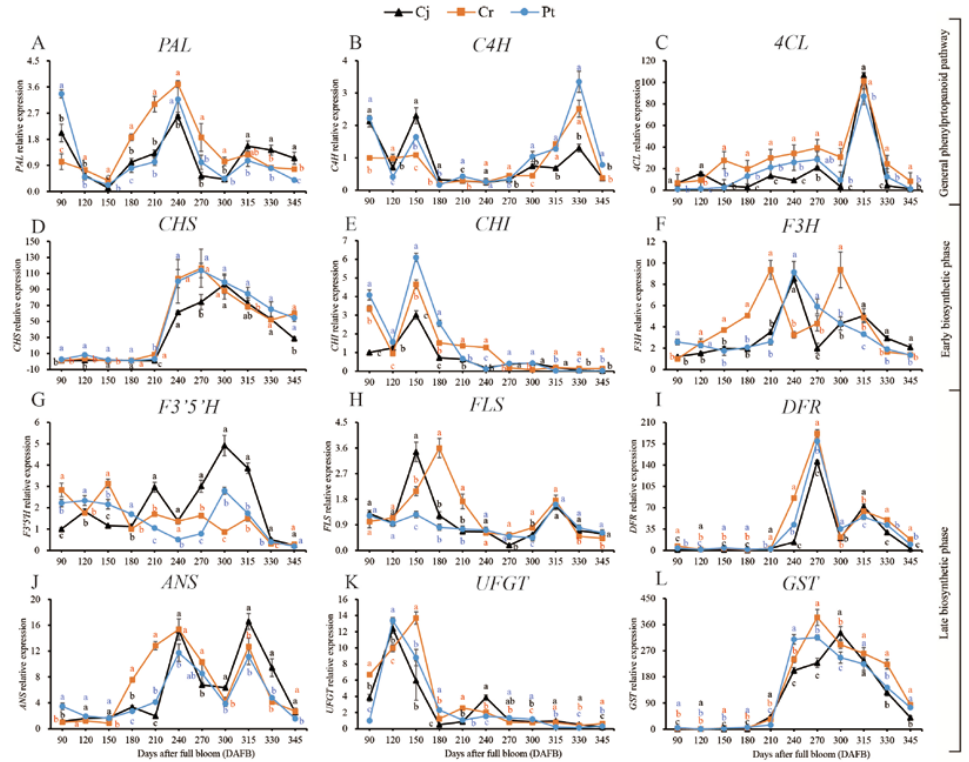
Figure 7. Dynamic changes of gene expression of anthocyanin biosynthesis pathway of blood orange grafted onto different rootstocks during fruit development and ripening: ( A – L ) PAL, C4H, 4CL, CHS, CHI, F3H, F 3′5′H, FLS, DFR, ANS, UFGT, GST.